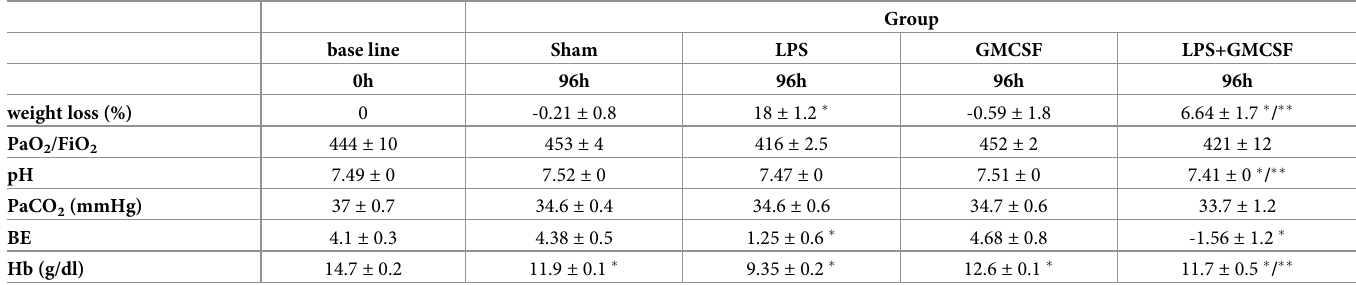
Table 1. Weight and blood gas